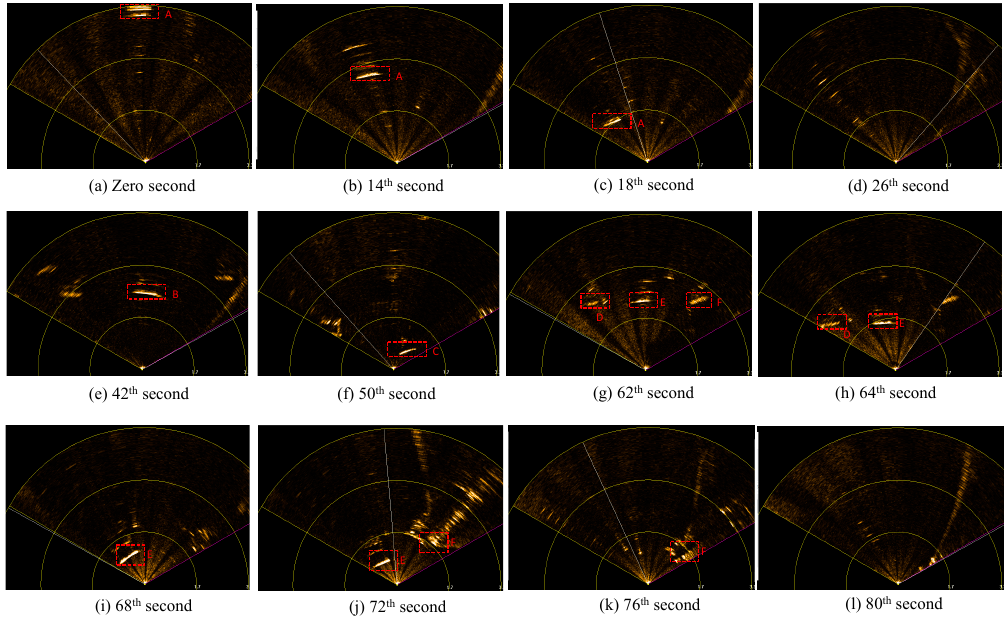
Figure 14. Images of the scanning sonar. The obstacle was marked with a red dash line.